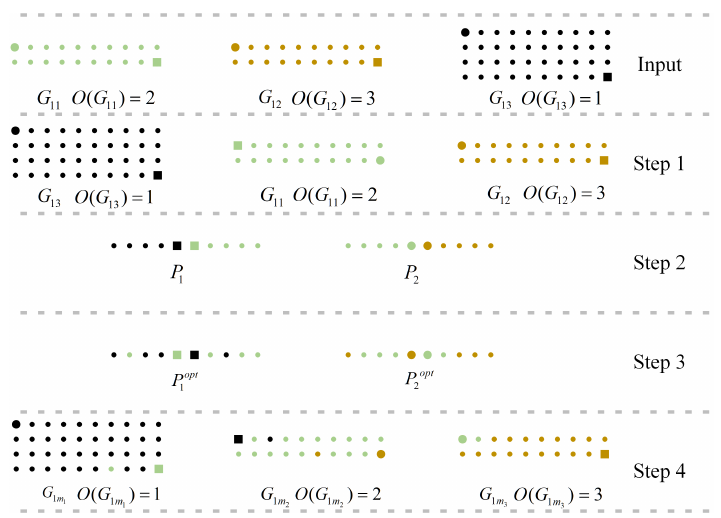
Figure 4. The major processes of TS_2-opt for optimizing three